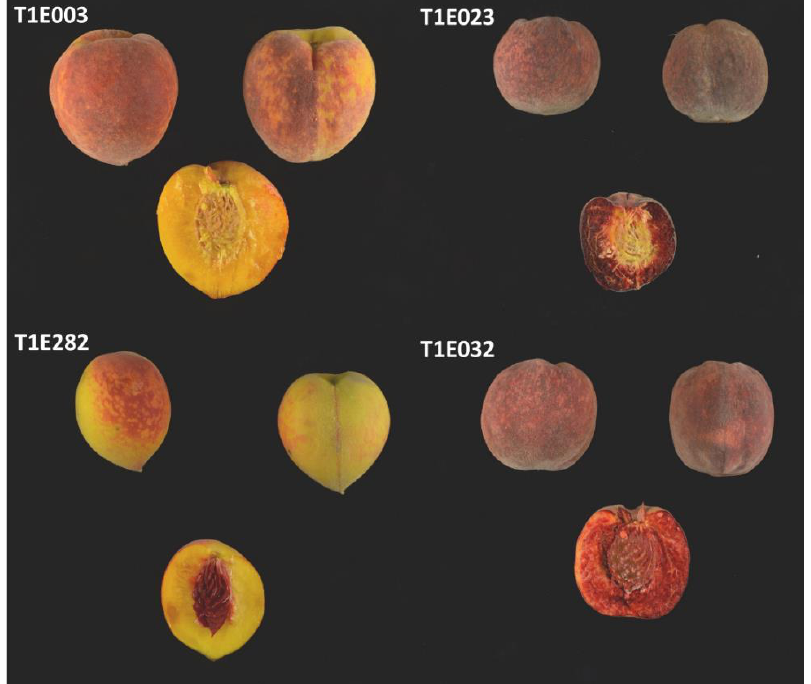
Figure 5. Images of different fruit of different T1E individuals with yellow flesh and yellow CAS (T1E003), red flesh and yellow CAS (T1E023), yellow flesh and red CAS (T1E282) and red flesh and red CAS (T1E032).